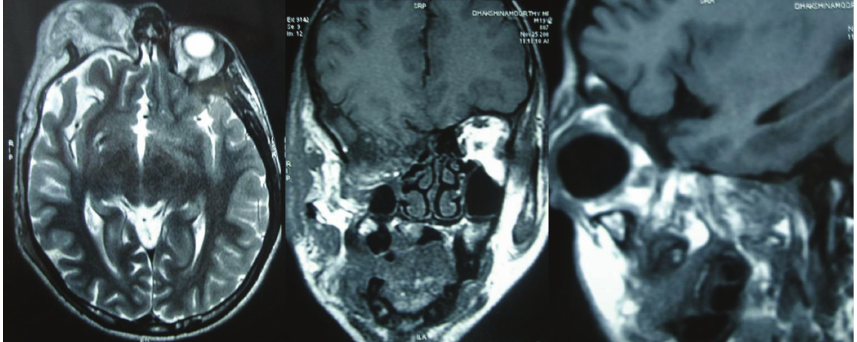
Figure 2: MRI of the brain axial, coronal, and sagittal views showing the absence of right sphenoid wing with herniation of the temporal lobe.